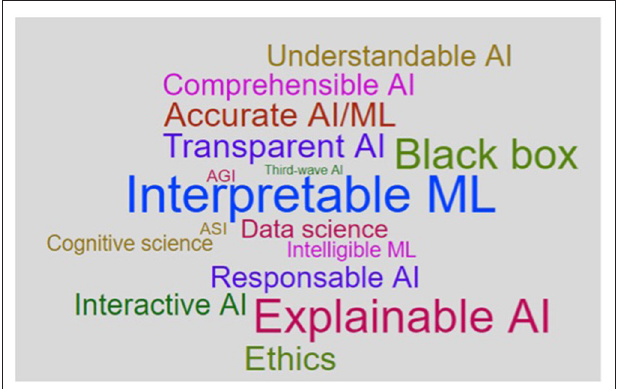
FIGURE 2 | XAI Word Cloud created by Adadi and Berrada